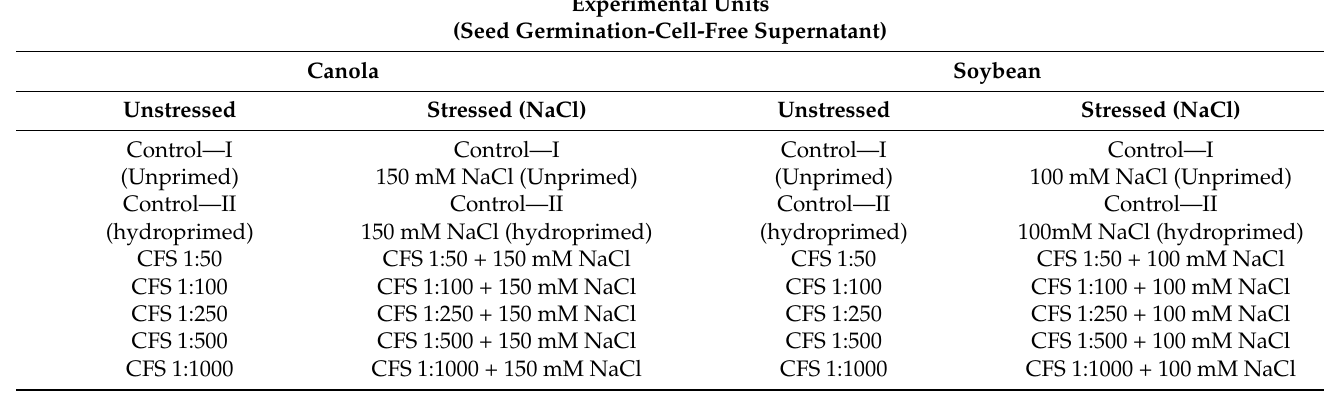
Table 2. Cell-free supernatant treatments for canola and soybean seed germination. Experimental